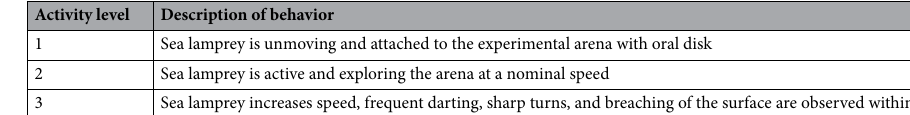
Table 1. Ethogram used to analyze behavioral responses to odor treatments in BORIS software. Activity levels were used to calculate activity